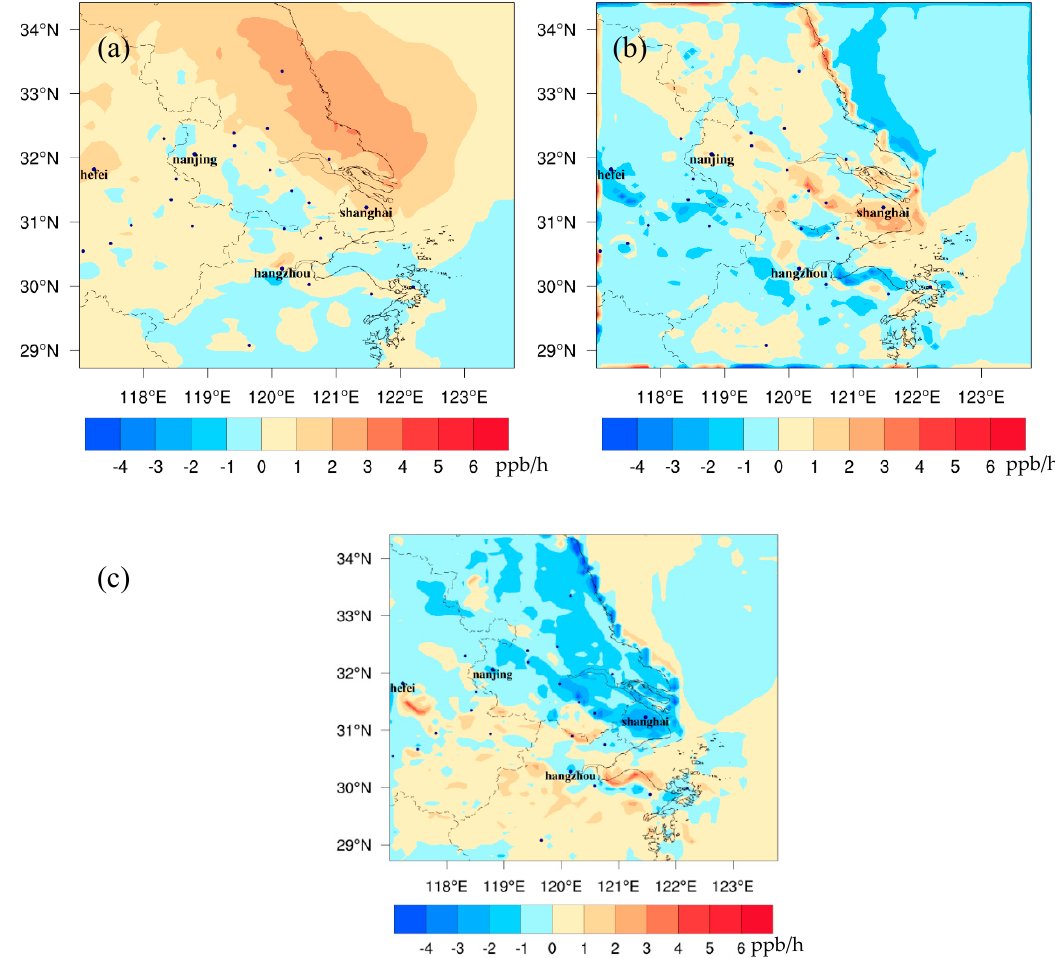
Figure 7. The spatial distribution of monthly averaged di ff erences of ( a ) Chem_O 3 , ( b ) Advt_O 3 , and ( c ) Vmix_O 3 between FUTMET and PREMET during the daytime (from 7:00 to 18:00 LST). Chem_O 3 represents the O 3 chemical production process. Vmix_O 3 means the contribution of vertical mixing and dry deposition to O 3 . Advt_O 3 means the contribution of horizontal and vertical